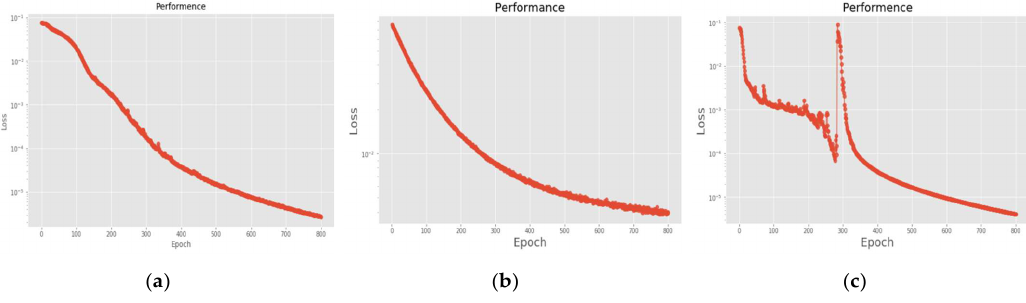
Figure 27. Loss function of wavelet 40-features dataset. ( a ) Wavelet + DNN. ( b ) Wavelet + CNN. ( c ) Wavelet + LSTM.